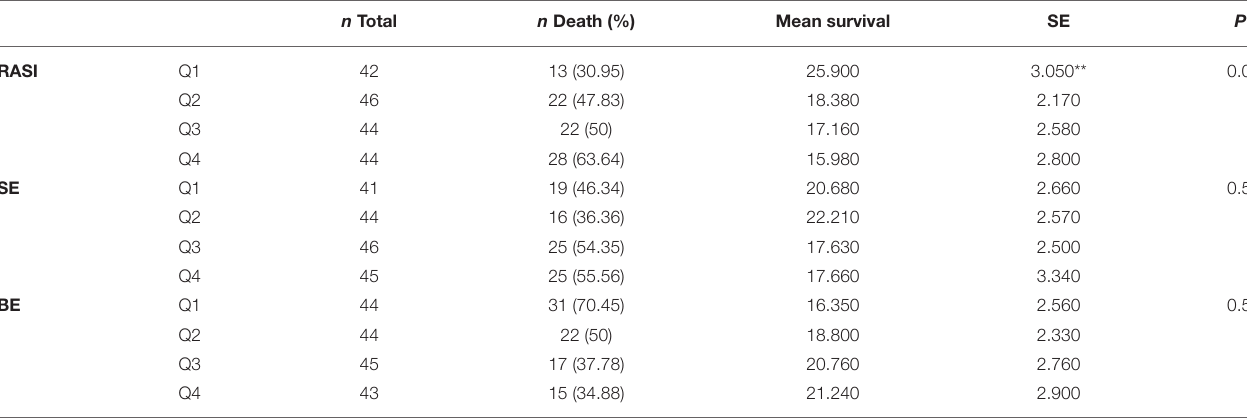
TABLE 3 | Mean survival of live and deceased patients. n Total n Death (%) Mean survival SE P